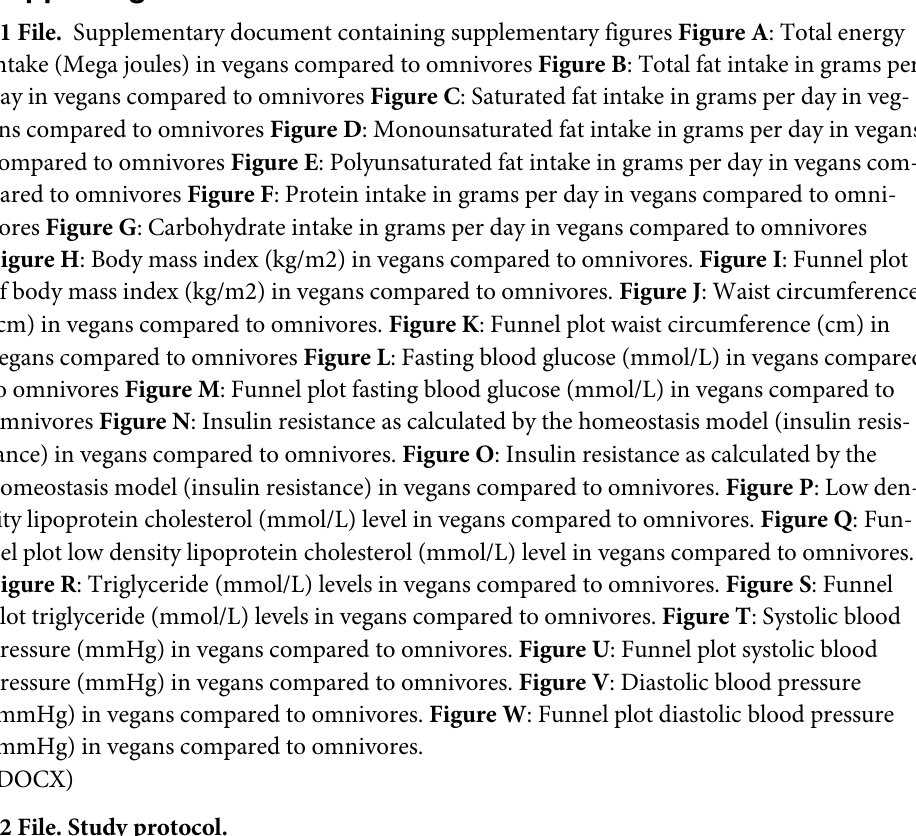
compared to omnivores Figure E : Polyunsaturated fat intake in grams per day in vegans com- pared to omnivores Figure F : Protein intake in grams per day in vegans compared to omni- vores Figure G : Carbohydrate intake in grams per day in vegans compared to omnivores Figure H : Body mass index (kg/m2) in vegans compared to omnivores. Figure I : Funnel plot of body mass index (kg/m2) in vegans compared to omnivores. Figure J : Waist circumference (cm) in vegans compared to omnivores. Figure K : Funnel plot waist circumference (cm) in vegans compared to omnivores Figure L : Fasting blood glucose (mmol/L) in vegans compared to omnivores Figure M : Funnel plot fasting blood glucose (mmol/L) in vegans compared to omnivores Figure N : Insulin resistance as calculated by the homeostasis model (insulin resis- tance) in vegans compared to omnivores. Figure O : Insulin resistance as calculated by the homeostasis model (insulin resistance) in vegans compared to omnivores. Figure P : Low den- sity lipoprotein cholesterol (mmol/L) level in vegans compared to omnivores. Figure Q : Fun- nel plot low density lipoprotein cholesterol (mmol/L) level in vegans compared to omnivores. Figure R : Triglyceride (mmol/L) levels in vegans compared to omnivores. Figure S : Funnel plot triglyceride (mmol/L) levels in vegans compared to omnivores. Figure T : Systolic blood pressure (mmHg) in vegans compared to omnivores. Figure U : Funnel plot systolic blood pressure (mmHg) in vegans compared to omnivores. Figure V : Diastolic blood pressure (mmHg) in vegans compared to omnivores. Figure W : Funnel plot diastolic blood pressure (mmHg) in vegans compared to